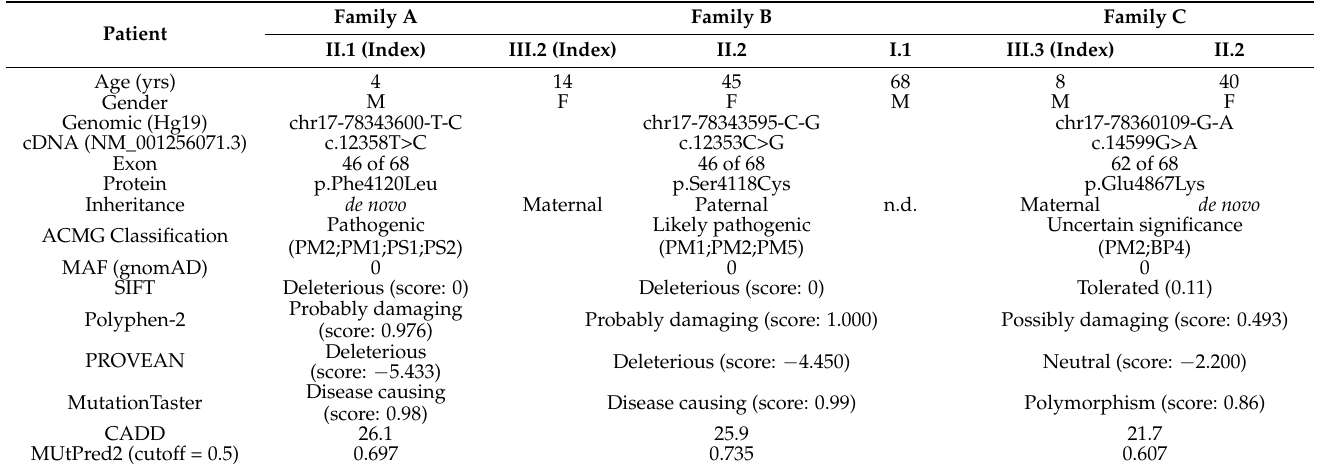
Table 2. Variants identified in RNF213. Segregation analysis and in silico evaluation of their pathogenicity.